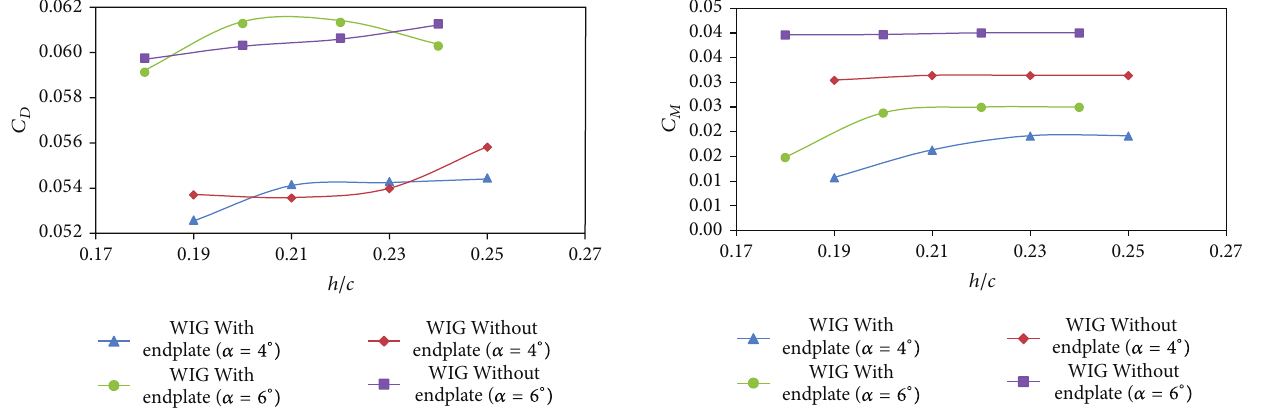
Figure 7: Drag coefficient ( 𝐶 𝐷 ) of WIG craft model with and without endplates versus ground clearance ( ℎ/𝑐 ) at different angles of attack.